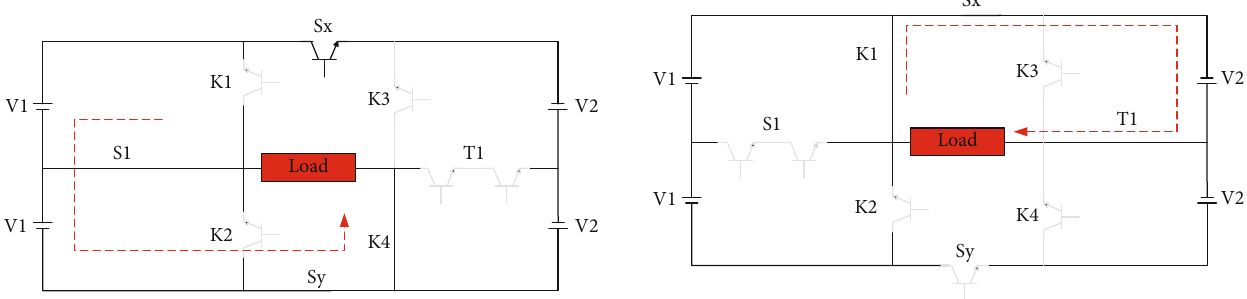
Figure 4: Current fl ow for the 2 nd switching pattern.